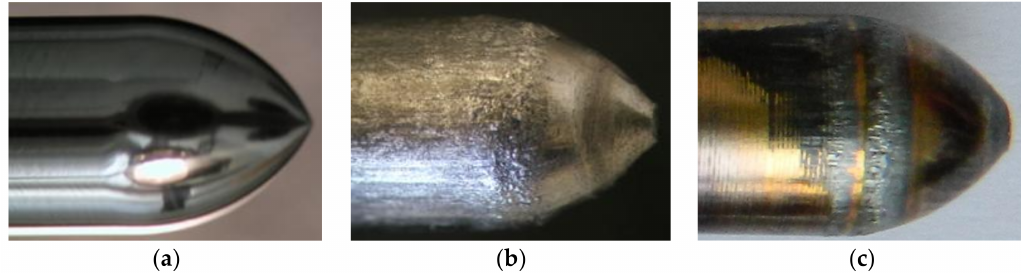
Figure 11. The surface of the hole-flanging punch: ( a ) initial state (tool steel 1.3343); ( b ) tool steel after 20,000 strokes; ( c ) tool steel with the TiCN-MP coating after 120,000 strokes.